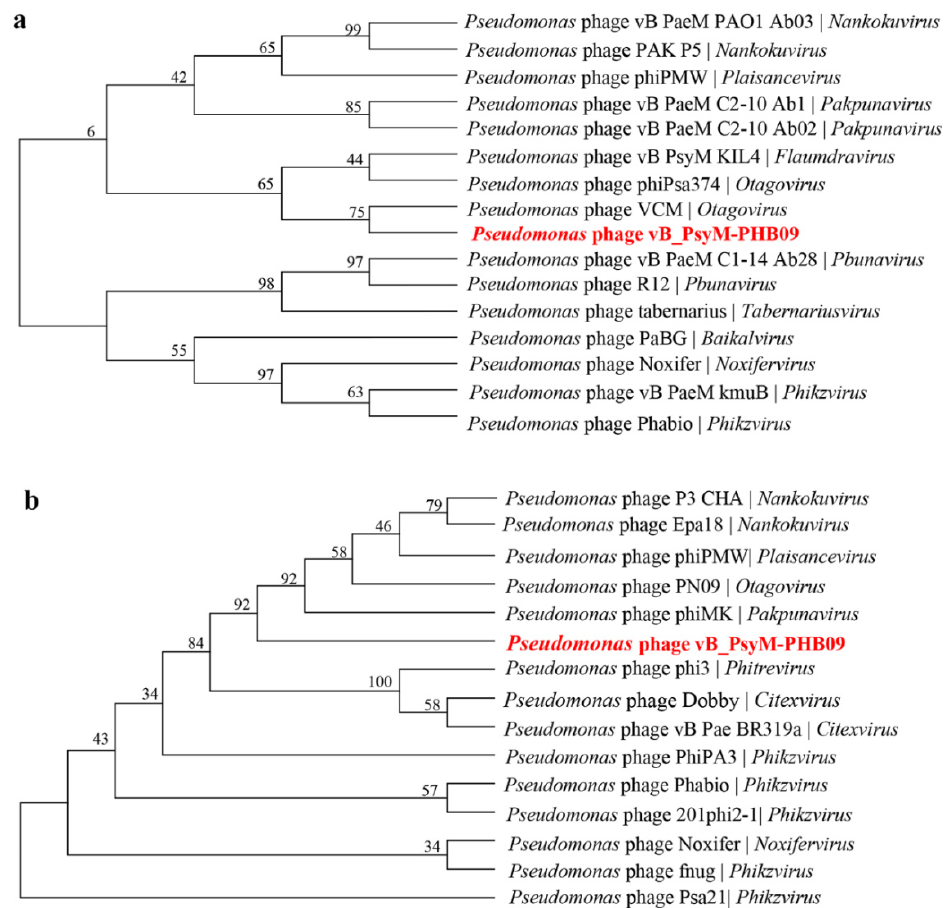
Figure 9. Phylogenetic relationship of phage PHB09. ( a ) Phylogenetic tree based on the amino acid sequences of the terminase large subunits. ( b ) Phylogenetic tree based on the amino acid sequences of major capsid proteins.